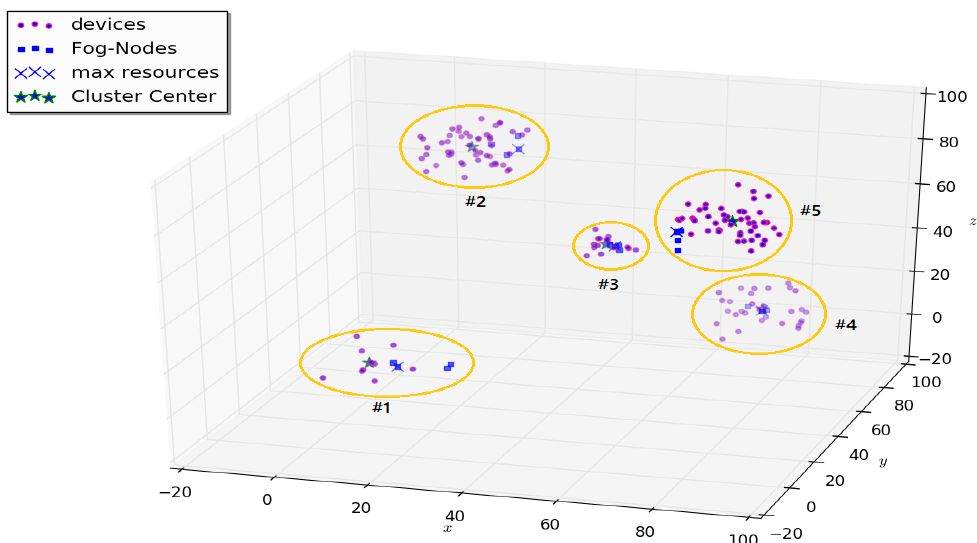
Figure 9. Algorithm results (position 1).